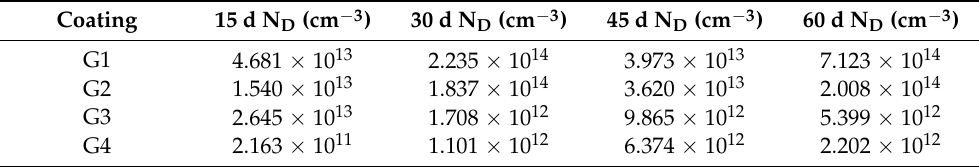
Table 3. Each coating’s carrier density for 15 d, 30 d, 45 d, 60 d in 20% Seawater.